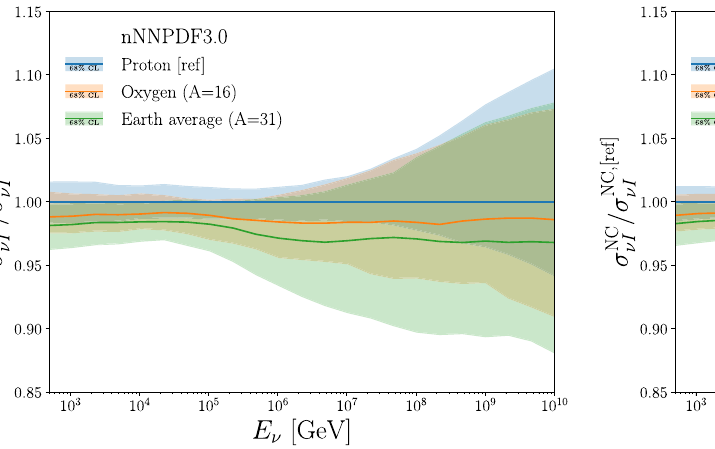
the uncertainty bands represent the nPDF 68% CL intervals. The pre- diction are normalised with respect to the A = 1 central value